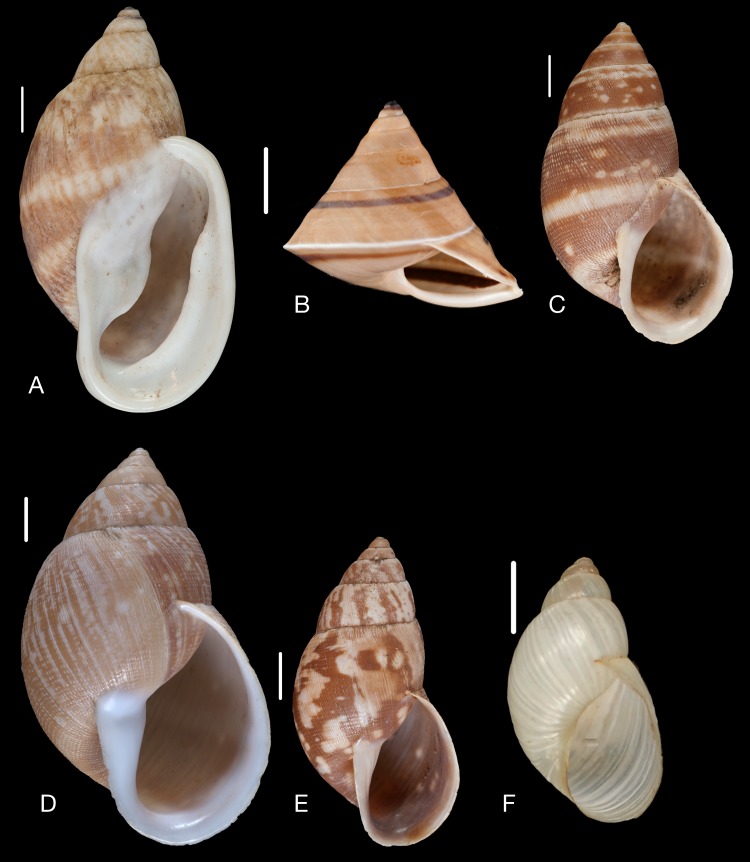
Material collected by the CCP.(A–F) Bulimulidae. Otostomus signatus (Spix in Wagner, 1827), MNCN 15.05/13371, (A) ventral view; Oxychona bifasciata (Burrow, 1815), MNCN 15.05/13128, (B) ventral view; Scutalus mutabilis (Broderip in Broderip & Sowerby I, 1832), MNCN 15.05/13382, (C) ventral view; Scutalus proteus (Broderip in Broderip & Sowerby I, 1832), MNCN 15.05/13390, (D) ventral view; Scutalus versicolor (Broderip in Broderip & Sowerby I, 1832), MNCN 15.05/13146, (E) ventral view; Stenostylus colmeiroi (Hidalgo, 1872), MNCN 15.05/3301, (F) ventral view. Scale line 5 mm.